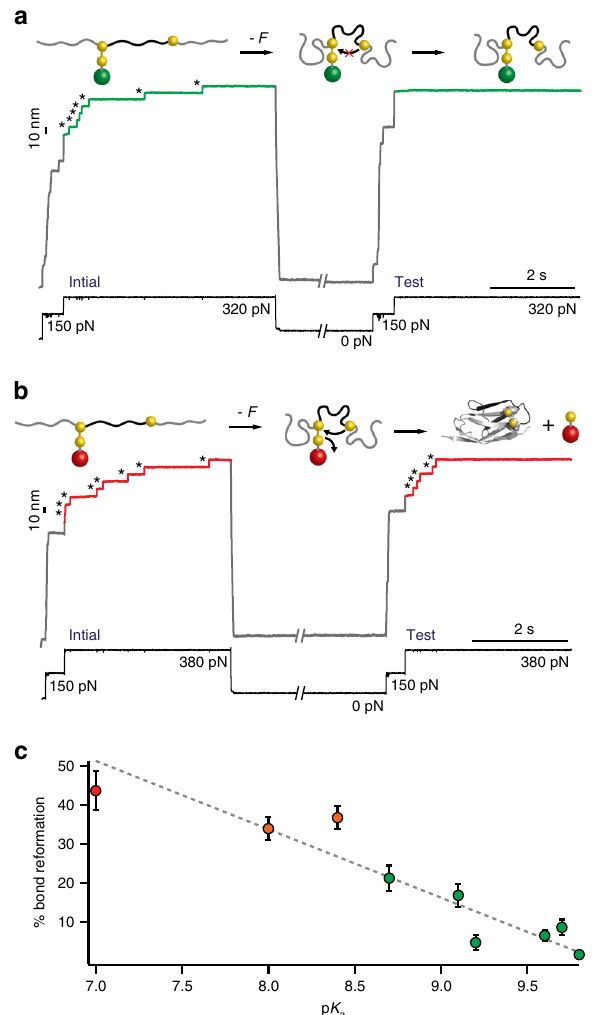
Fig. 3 Mechanical activation of thermodynamically unfavoured reactions induces chemical reversibility. a Disul fi de bond reduction by mesna ( Δ G ° = − 6.7 kcal mol − 1 , green) results in a low-energy mixed disul fi de that cannot reversibly reform the initial disul fi de bond in the absence of force, marked by the absence of ~10 nm steps in the test pulse. b Conversely, reduction by Cys-ME ( Δ G ° = + 7.3 kcal mol − 1 , red) gives rise to subsequent disul fi de bond reformation, hallmarked by the ~10 nm stepwise increase in the test pulse. c The extent of disul fi de bond reformation for all the tested compounds (green, thermodynamically allowed; orange, marginally allowed and red, thermodynamically unfavoured) exhibits a linear correlation with the p K a ( r 2 = 0.88); (From left to right n = 16, 35, 30, 24, 32, 33, 53, 31, and 39; error bars: